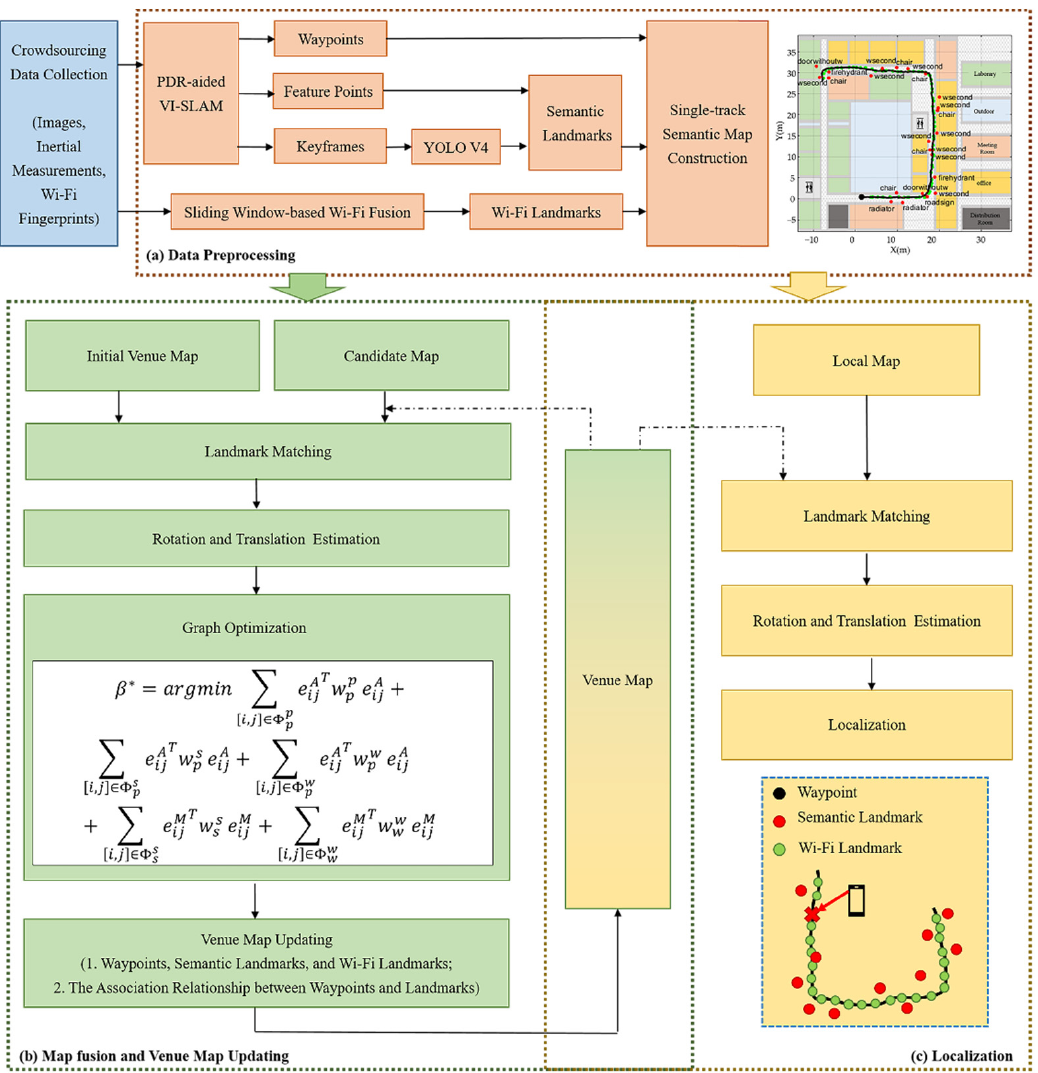
Figure 1. The system overview.